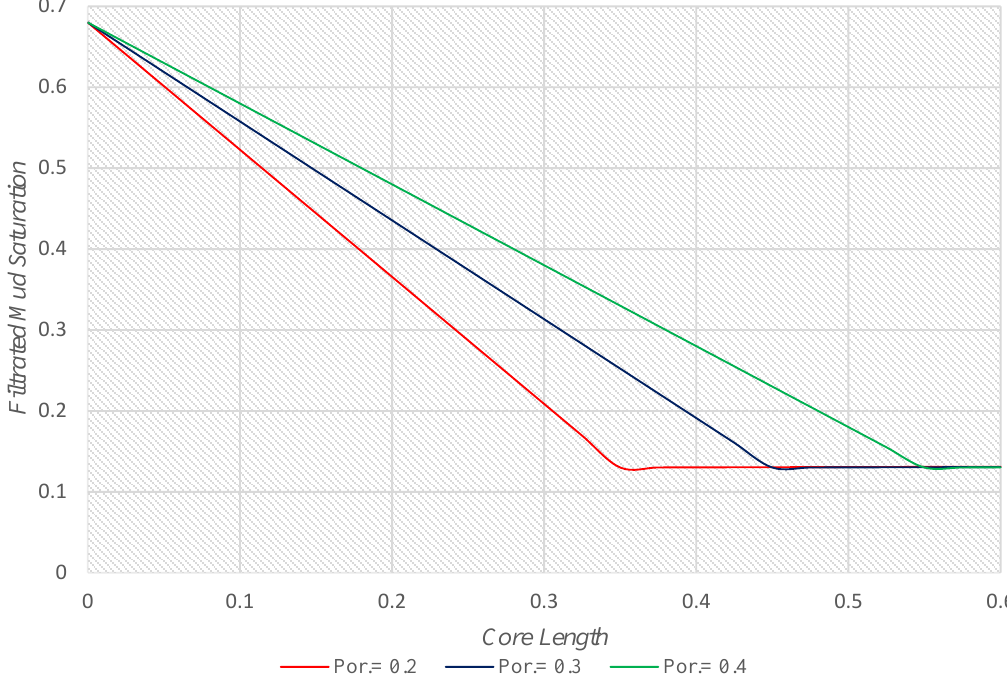
ff ect on the filtrated mud Figure 1. Porosity effect on the filtrated mud saturation. Figure 1. Porosity e